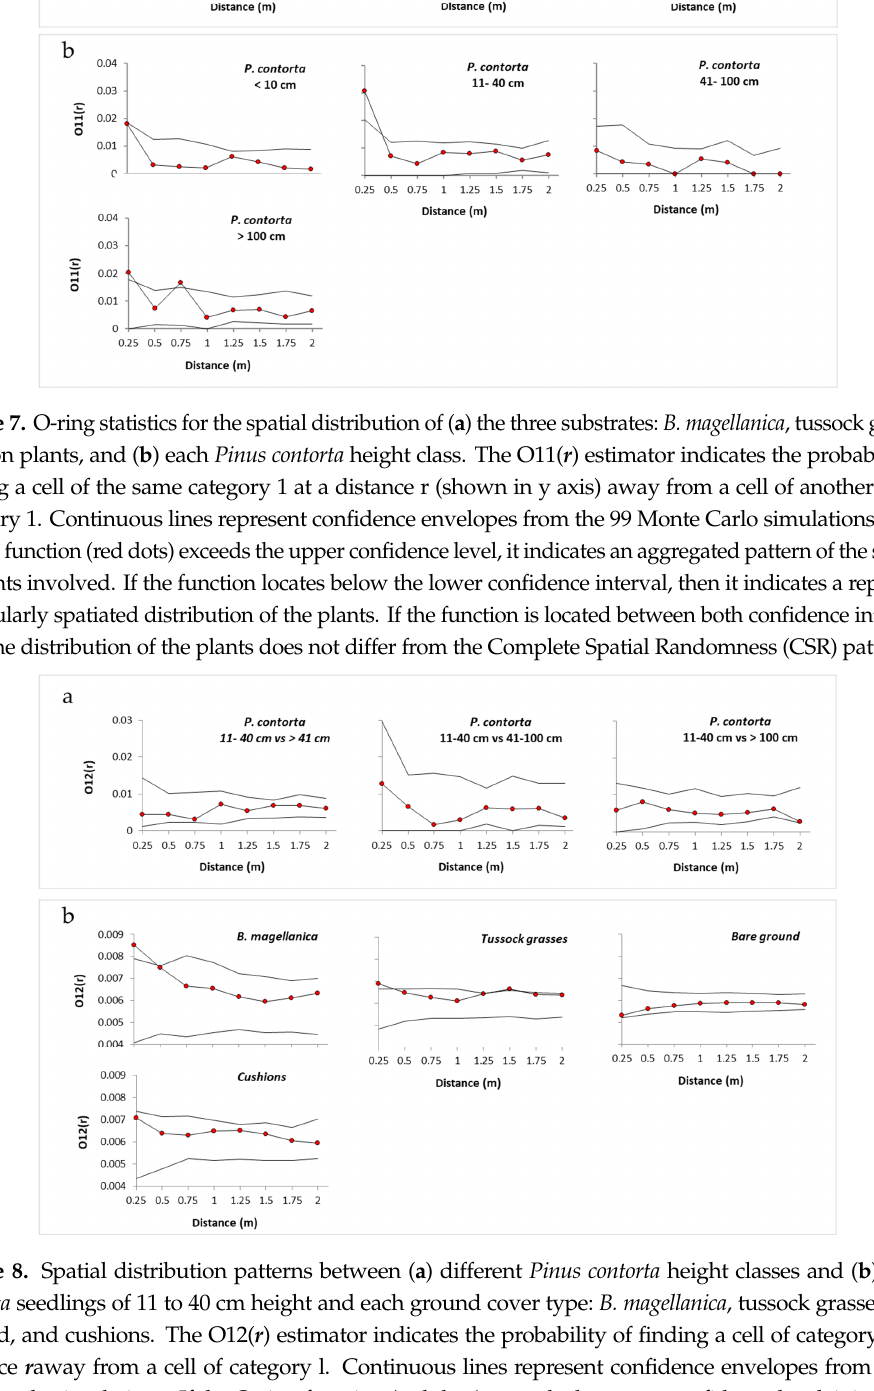
Table 2. Repeated measures ANOVA for the proportion of sowed seeds that emerged as seedling and survived the entire growing season at three sites in Coyhaique (nine measurements for each